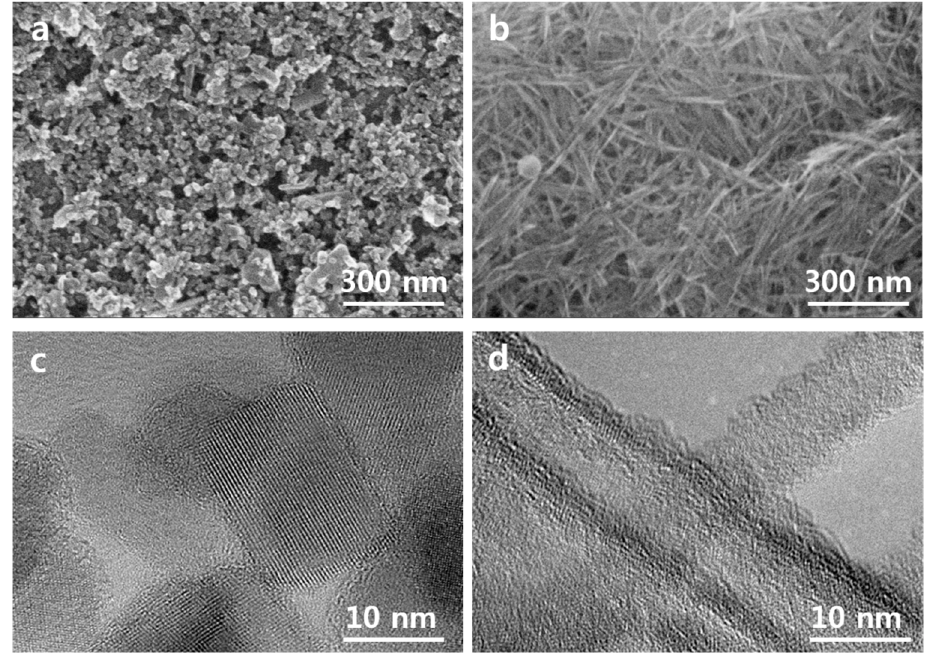
Figure 3. Scanning electron microscopy (SEM) micrographs of pristine ( a ) TiO 2 NPs and ( b ) NTs. high resolution transmission electron microscopy (HRTEM) images of pristine ( c ) TiO 2 NPs and ( d ) TiO 2 NTs.